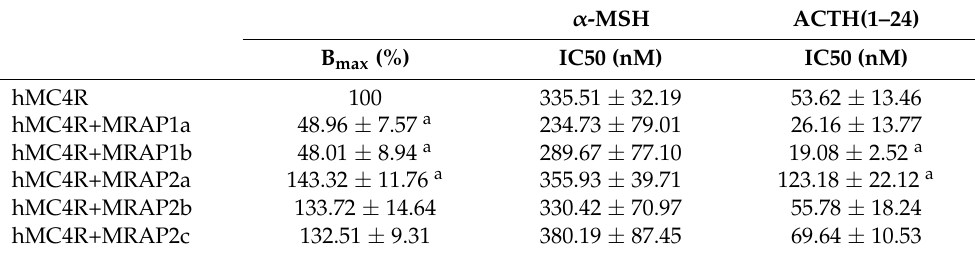
Table 3. The ligand-binding properties of hMC4R regulated by hMRAP1s and hMRAP2s.